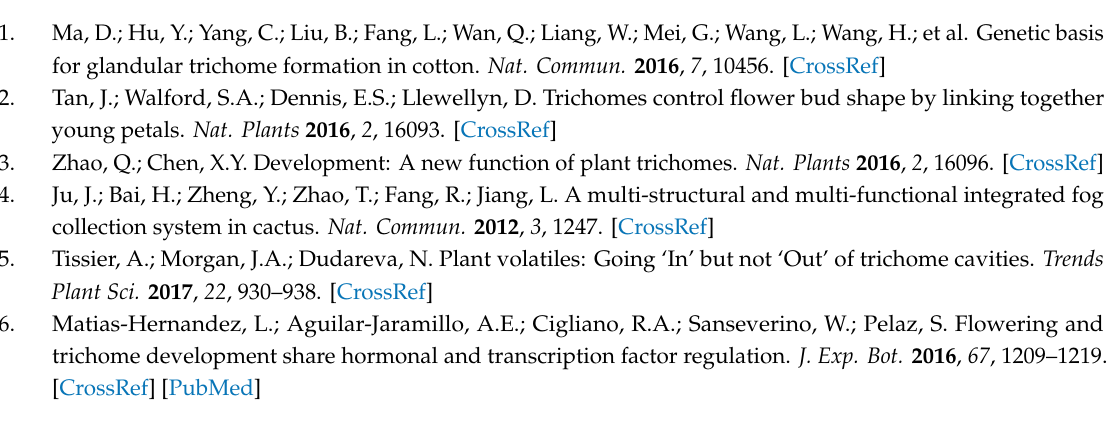
Figure S1: Global distribution of DEGs identified from the comparison of trichomes vs. leaves; Figure S2: Transcription factors identified from RNA-Seq analysis; Table S1: Primers used for qRT-PCR validation; Table S2: Summary of the RNA-Seq data obtained from trichomes and leaves; Table S3: Expression levels of key genes involved in the ca ff eine biosynthesis pathway, theanine biosynthesis pathway, and catechin biosynthesis